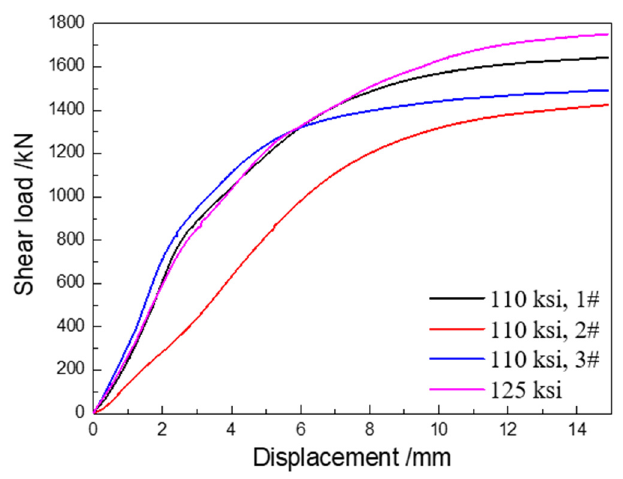
Figure 9. Shear load and displacement curve of cement-sheath casing.